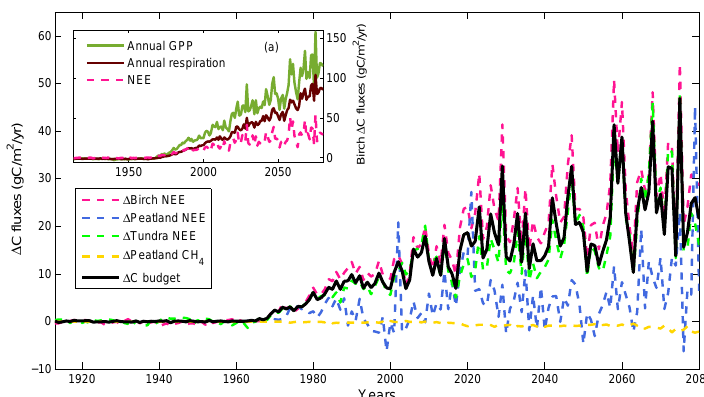
Figure 7. Carbon flux differences ( (cid:49) C fluxes) for different land-cover types with and without a CO 2 increase since 1960. Positive values of (cid:49) C NEE imply a higher uptake or a lower emission of CH 4 in the simulations with a CO 2 increase compared to the simulation without a CO 2 increase. For the birch forest land-cover type, the differences in gross primary production (GPP) and ecosystem respiration are shown in the panel (a) , where the positive values indicate a higher photosynthesis rate and a higher respiration rate in the simulations with a CO 2 increase compared to the simulations without a CO 2